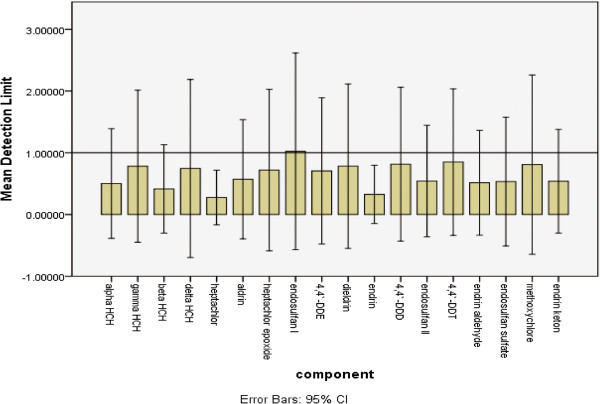
Detection Limit (ng/L) error bar for water matrix.